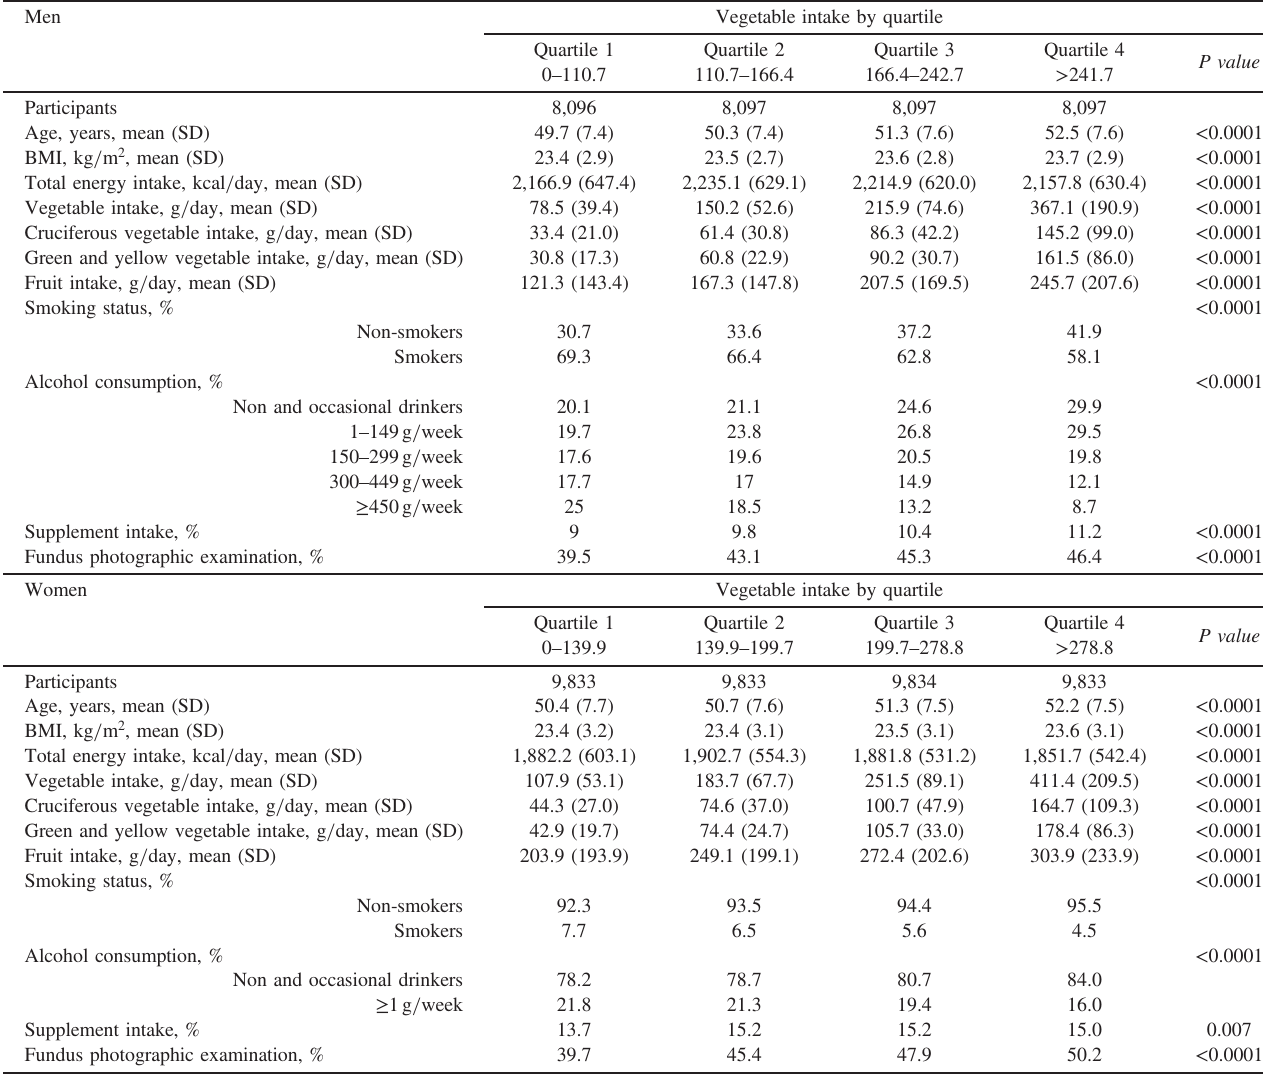
Table 1. Baseline characteristics of participants according to quartile of vegetable intake by sex